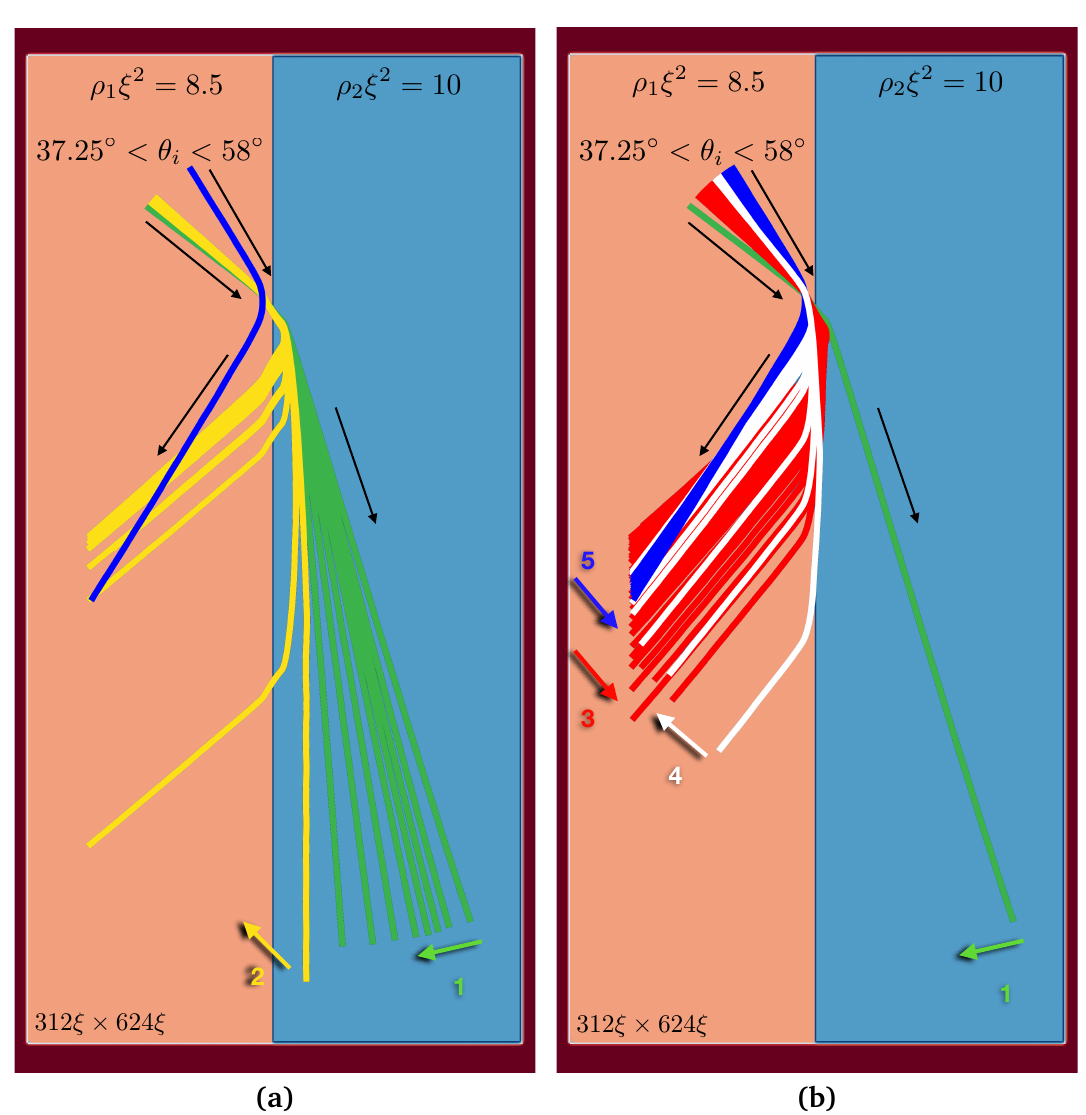
= 17.9 ξ ) across the large step Figure 5: The trajectories of low energy dipoles ( d i /ρ = 8.5 / 10) within a range of incident angles θ ( ρ extending from 37.25 ◦ to i 1 2 = 39.7 ◦ . The figure is divided into two parts for 58.0 ◦ . Here the critical angle is θ c clarity, with each part containing the same bounding trajectories defining the angular range. The coloured arrows point from the outgoing trajectory with the smallest incident angle towards the outgoing trajectory with the largest incident angle for each regime, and the black arrows indicate the direction of dipole propagation. (a) : The first regime of behaviour is shown by the green dipole trajectories. In this regime the dipoles undergo refraction. Their incident angles are all below the critical angle, and their outgoing angle increases as a function of the incident angle. The second regime = 39.25 ◦ . (b) : The third and is shown by the yellow trajectories, beginning with θ i fourth regimes are given by the red and white dipole trajectories respectively. The = 54.25 ◦ . See fifth regime is given by the blue dipole trajectories beginning with θ i text for a description the